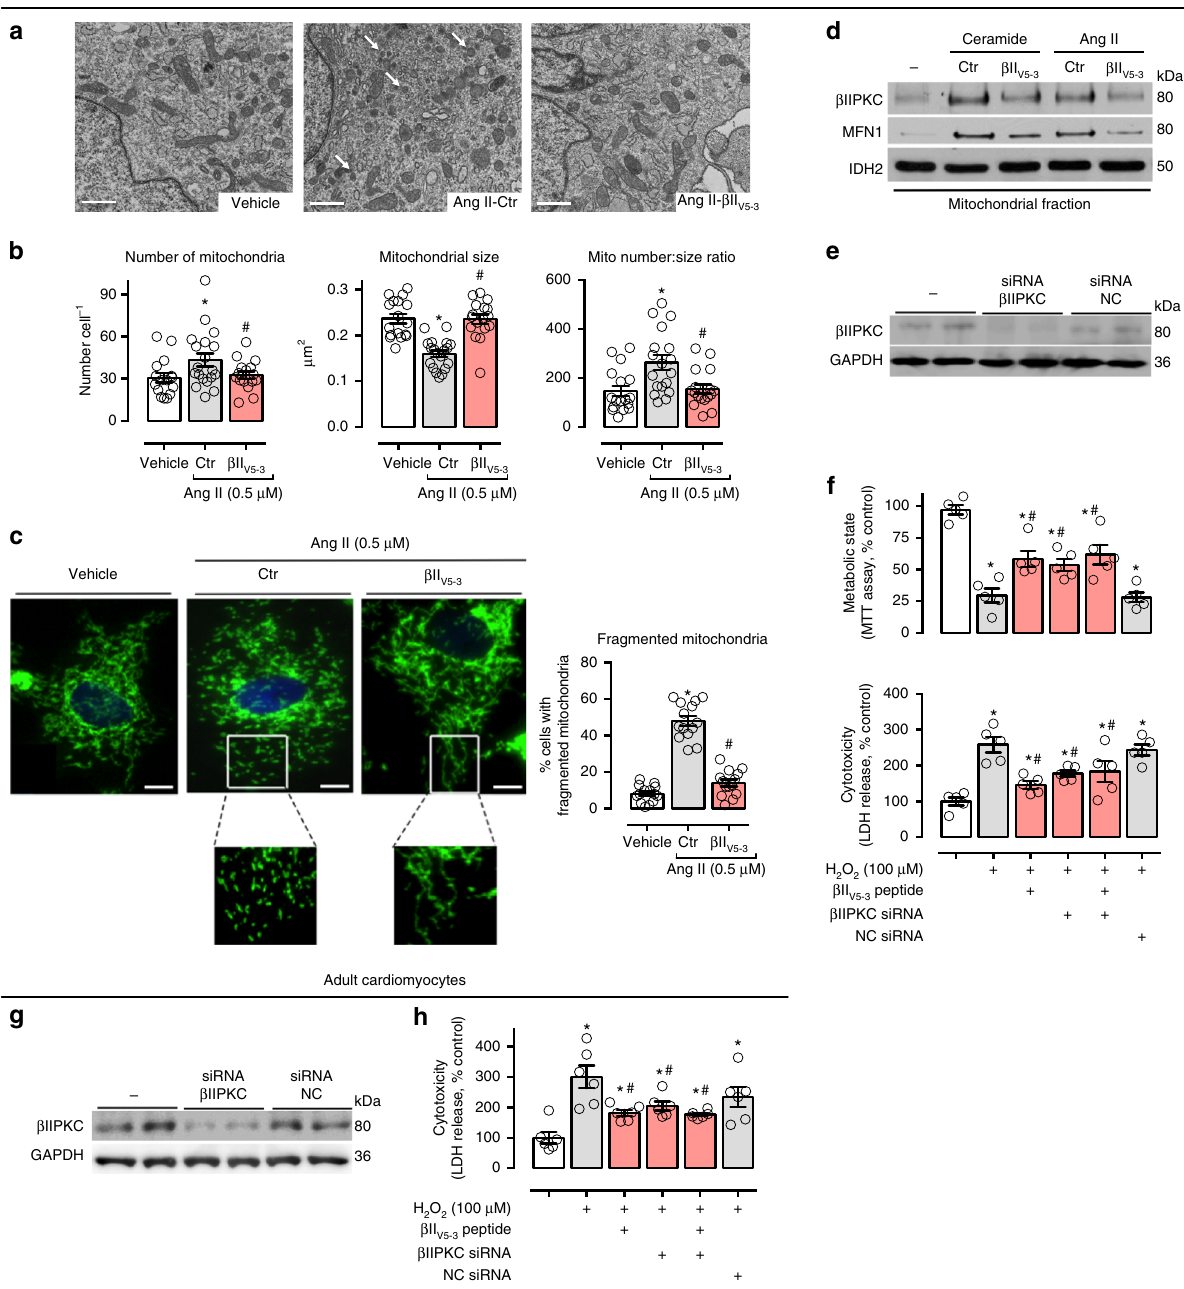
Fig. 2 β IIPKC inhibition reduces mitochondrial fragmentation in cultured cardiomyocytes. a Representative transmission electron micrographs (white arrows indicate small mitochondria, scale bar: 1 μ m) and b quanti fi cation of mitochondrial number and size in the transmission electron micrographs of neonatal rat cardiomyocytes in culture treated with TAT (carrier) or β II V5-3 peptides for 30 min followed by incubation with angiotensin II (0.5 µ M for 4 h, n = 5 per group). c Cells were then stained with anti-Tom20 antibody (green) and Hoechst stain and counted. Mitochondrial morphology was analyzed using a 63x oil immersion lens (scale bar: 5 μ m). The analysis was done in a blinded fashion. The boxed area in each upper panel is enlarged under each micrograph. d Neonatal rat cardiomyocytes in culture were treated with TAT or β II V5-3 peptides for 30 min followed by incubation with either C2-ceramide (40 μ M) or angiotensin II (0.5 µ M) for 4 h. After incubation, the mitochondrial levels of β IIPKC and Mfn1 were detected using speci fi c antibodies (representative blot of three independent experiments). e Neonatal rat cardiomyocytes in culture were transfected with β IIPKC silence RNA ( β IIPKC- siRNA) or control (NC-siRNA). f 48 h later cells were treated with TAT or β II V5-3 peptides for 30 min followed by incubation with H 2 O 2 (100 µ M, 24 h). After incubation, cell viability and toxicity were measured by MTT assay and LDH release, respectively. g Adult rat cardiomyocytes in culture were transfected with β IIPKC-siRNA or NC-siRNA ( n = 6 per group). h 24 h later cells were treated with TAT or β II V5-3 peptides for 30 min followed by incubation with H 2 O 2 (100 µ M, 1 h). Cell toxicity was measured by LDH release. Data are means ± SEM. * P < 0.05 vs. control cells. # P < 0.05 vs. Ang II-